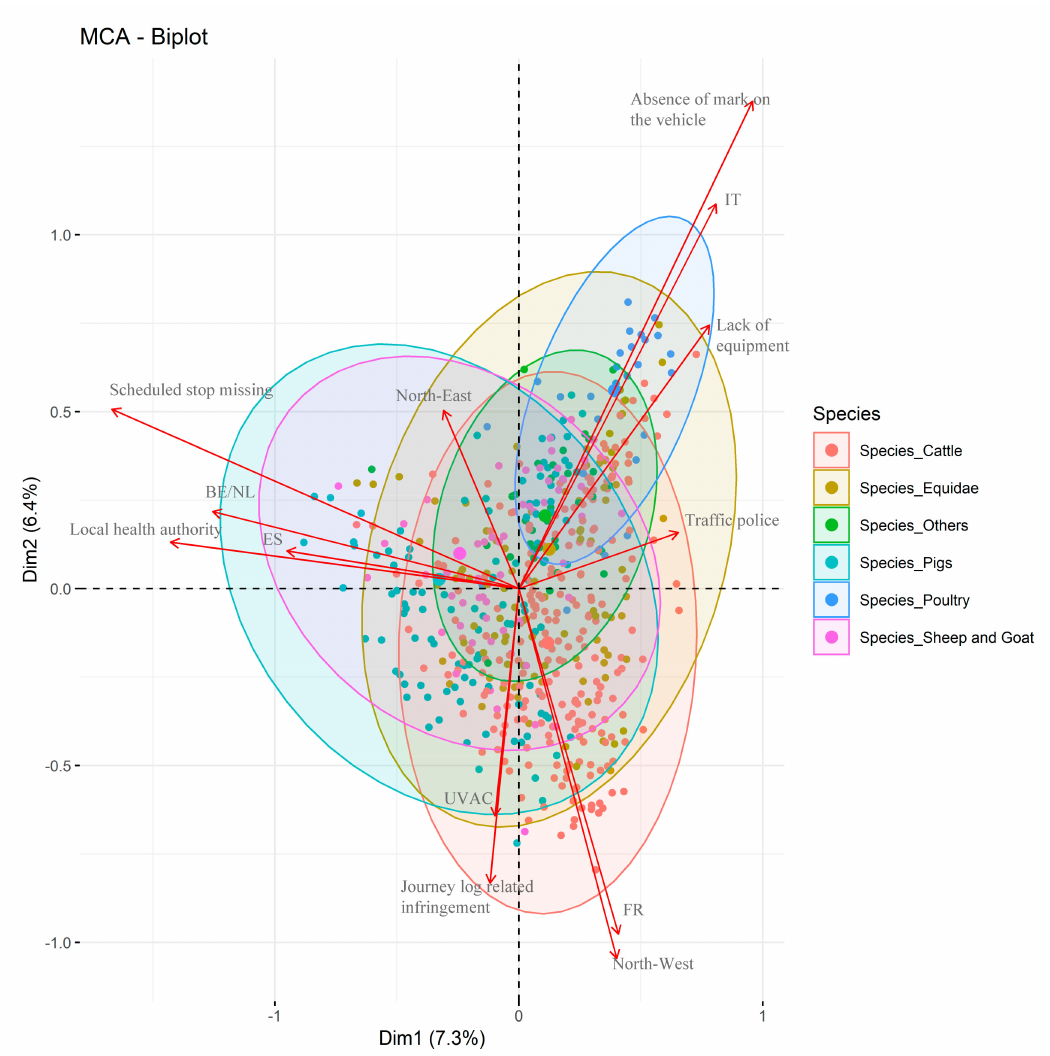
Figure 4. Multiple correspondence analysis biplot with the infringements distinguished on the basis of the transported animal species and the vectors representing the variables with the greatest e ff ect on the two new dimensions (Dim1 and